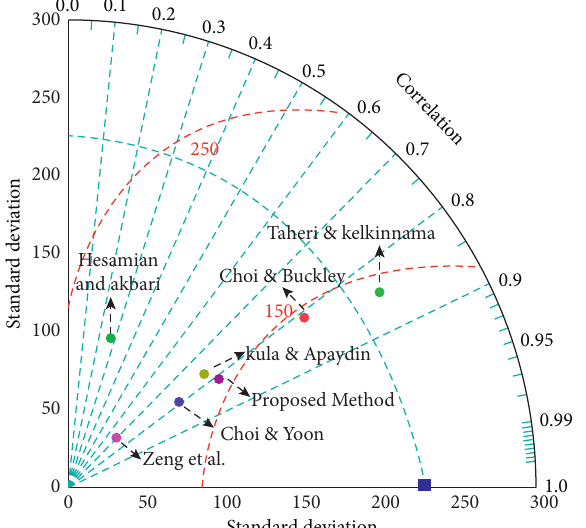
Figure 14: Comparison of performances of all models with Taylor’s diagram for the centers in Example 9. The rectangle on the x -axis represents the observations, and the red-dashed contours indicate the centered Root Mean Square Errors.